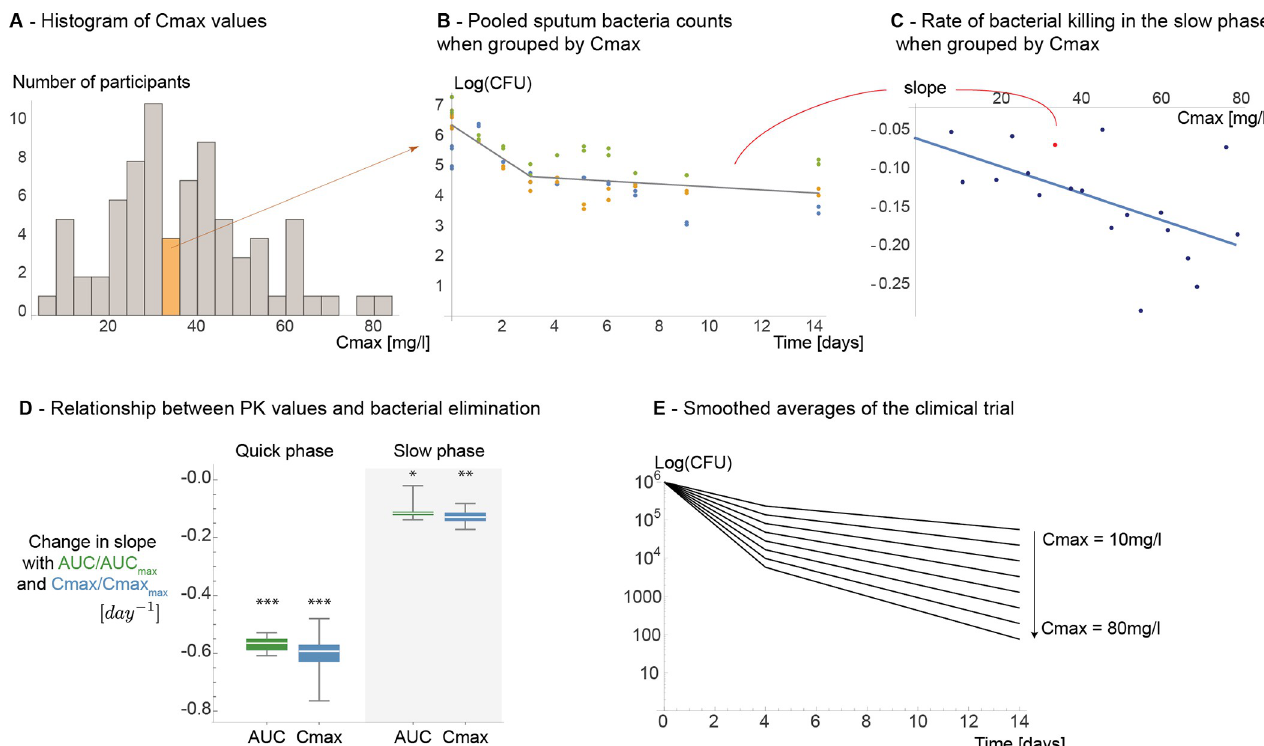
Fig 2. Overview of the fitting process and the relationship between the decline rates of bacteria and pharmacokinetic measures. We have grouped participants ( Fig 2A ) by forming equal groups within the pharmacokinetic measures. For each group, we pooled the bacterial count measurements (Y-axis) of all participants (dots, here one colour corresponds to one participant) and fitted biphasic curves to them (solid line) ( Fig 2B ). Next, we analysed the relationship between the groups’ median pharmacokinetic measurements (X axis) and the properties of the fitted curves (Y axis) ( Fig 2C ). Fig 2D summarizes the dependence of the decline rates in the quick and slow phases on AUC and Cmax . Here, we have normalized the values (by dividing with the maximum), in AUC max Cmax max order to be able to show that both measures produce the same result but with different errors. Fig 2E demonstrates how this affects the bacterial count measurements (X-axis) over time (Y-axis). The curves were made with Eq (1), starting at 10 6 CFU/ml bacteria, using day 4 as the day of transition, with the obtained fits for decline rates (see Table 1), and Cmax values of 10, 20, 30 ... 80 [mg/l] (in the dataset the Cmax values range from 7.7 to 85.6